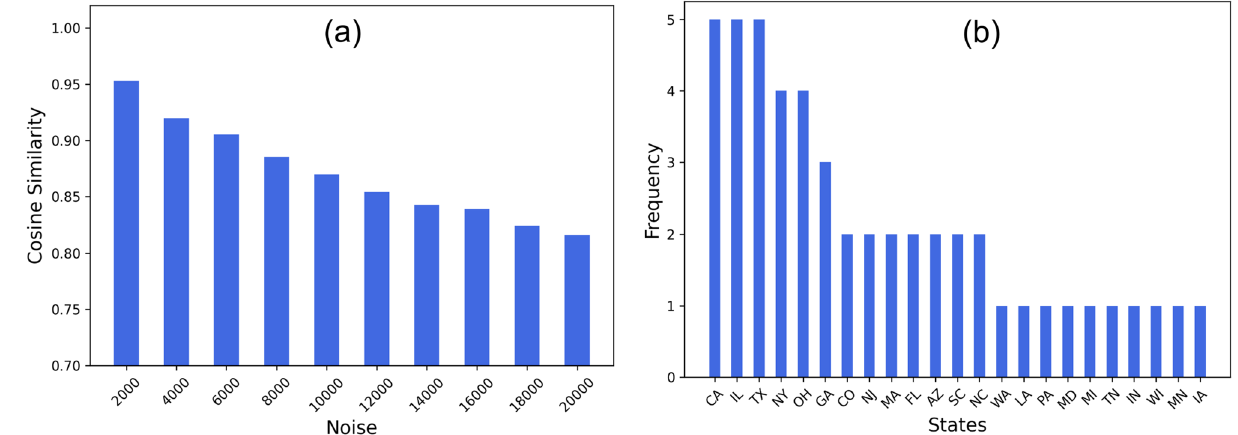
Figure 7. Effectiveness of network inference in predicting contagion. ( a ) Cosine similarity between original network on US infected data and noise data created by adding random noise; ( b ) Frequency of states emerging as top 10 spreaders in five influence networks (one pre-lockdown January to mid-March 2020 and four post- lockdown mid-March to November